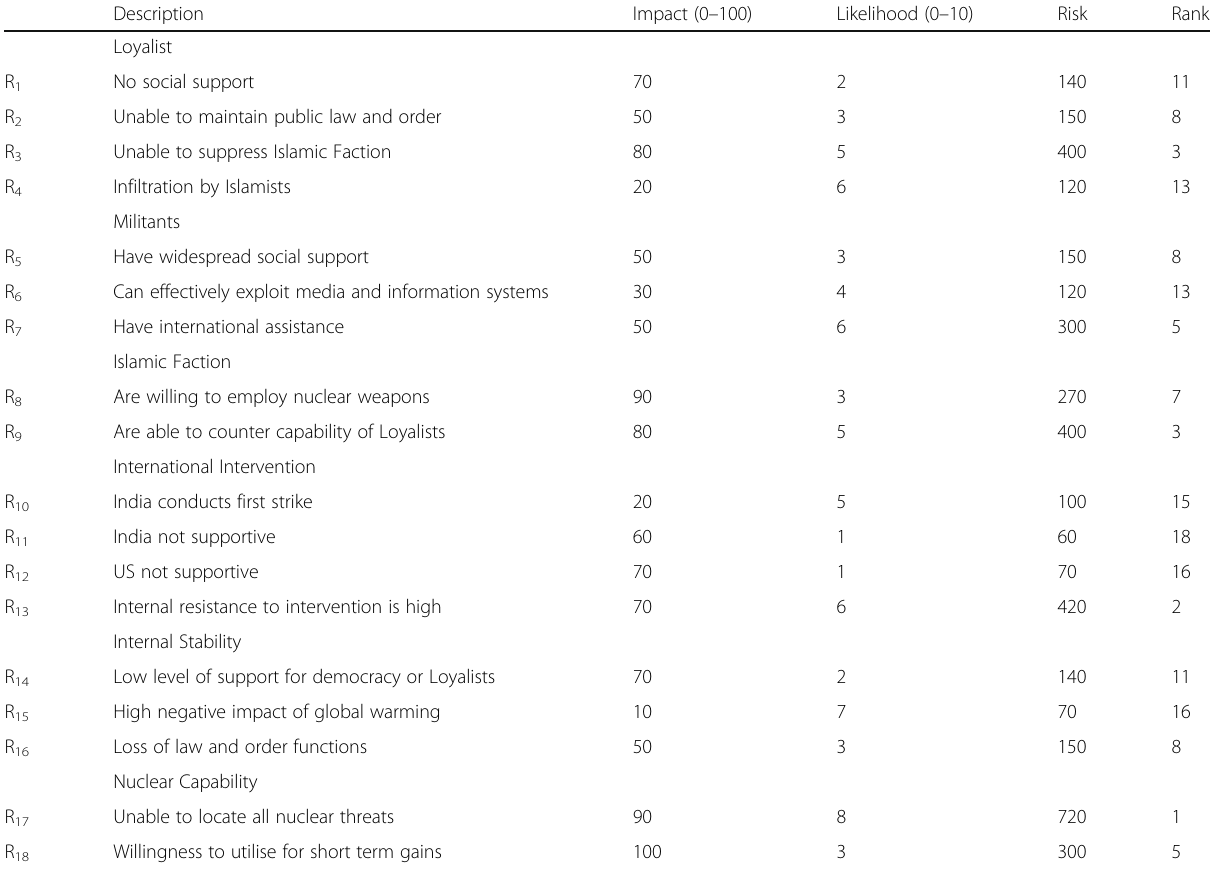
Table 5 Evaluating the risk of system components on the achievement of the objective Description Impact (0 –